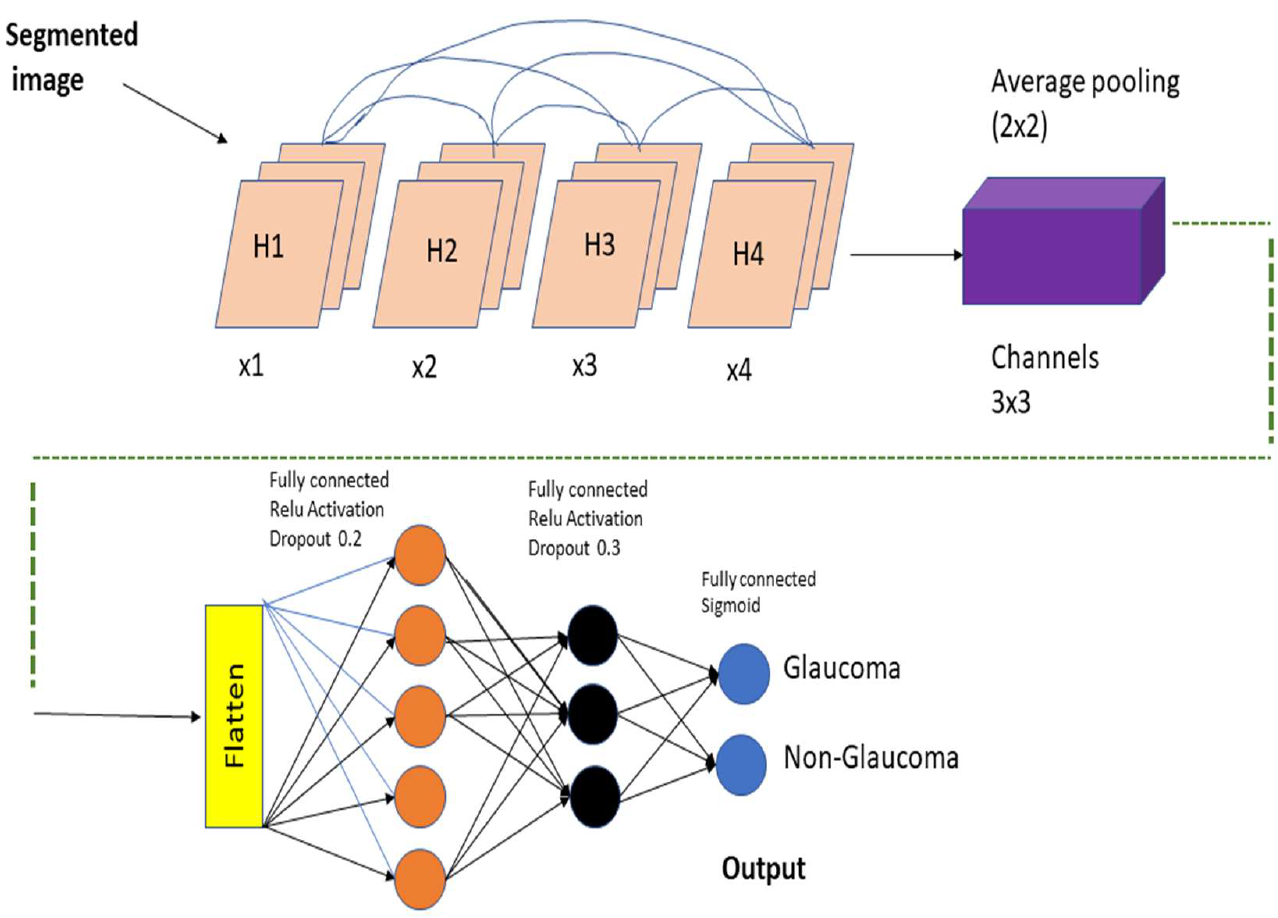
Figure 6. Feature extraction using pretrained DenseNet-201 model and classification using DCNN.